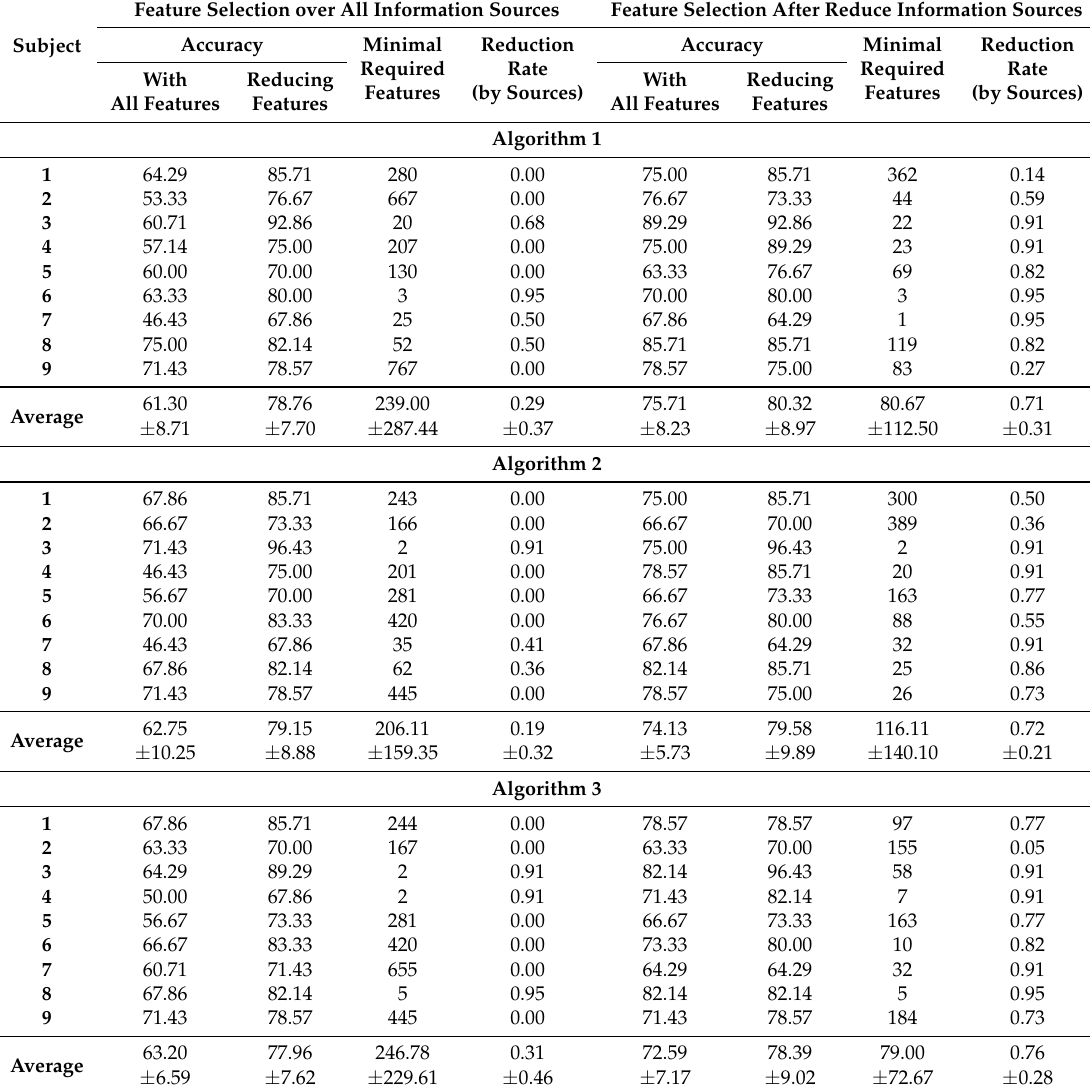
Table 8. Comparison of results applying feature selection by Fisher Score technique over the BCI data before and after the source reduction